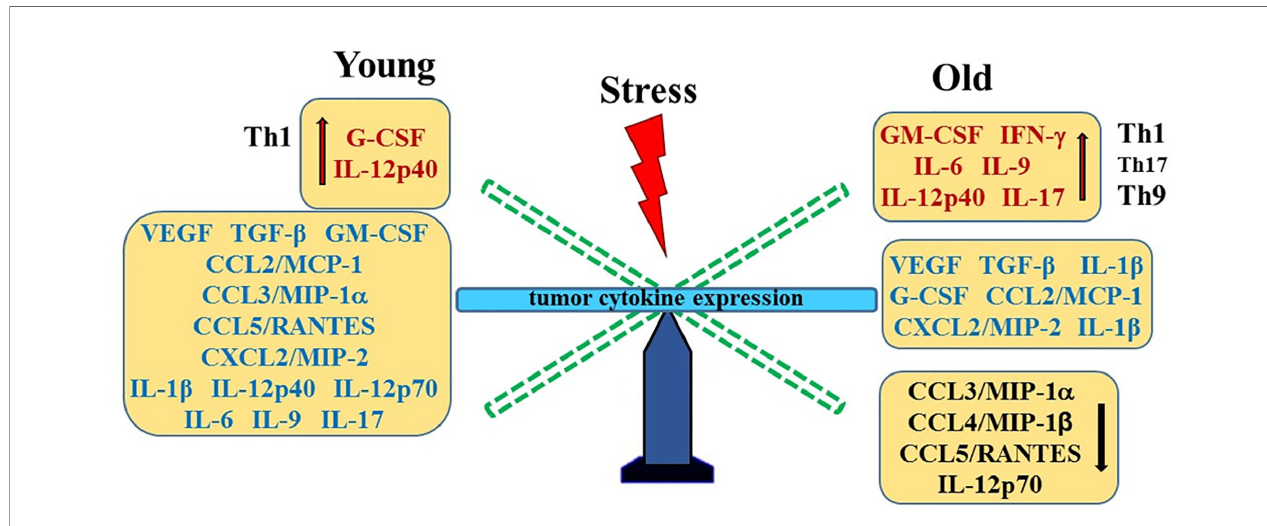
FIGURE 8 | Stress- and Age-Mediated Changes in Prostate Cytokine Expression. A summary of the changes in tumor chemokine/cytokine expression in young (left) and old (right) stressed mice is represented as a “ teeter-totter ’ with an increase or decrease in expression represented as an elevated or depressed bars, respectively. CCL, C-C Motif Chemokine Ligand; CXCL, (C-X-C motif) ligand 1; G-CSF, Granulocyte Colony-stimulating Factor; GM-CSF, Granulocyte/ Monocyte Colony-stimulating Factor; IFN, interferon; IL, interleukin; MCP, Monocyte Chemoattractant Protein-1; MIP, Macrophage In fl ammatory Protein; RANTES, Regulated upon Activation, Normal T Cell Expressed and Presumably Secreted; TGF, Transforming Growth Factor; Th, T-helper; VEGF, Vascular Endothelial Growth Factor